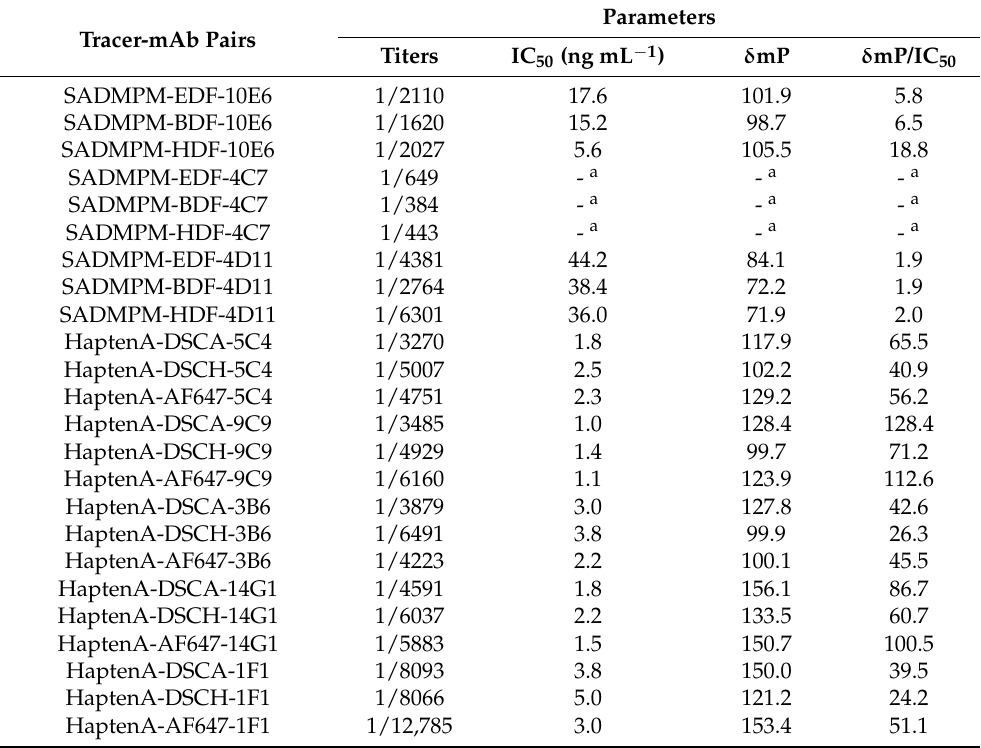
Table 1. Characteristics of each tracer–antibody pair in the BB